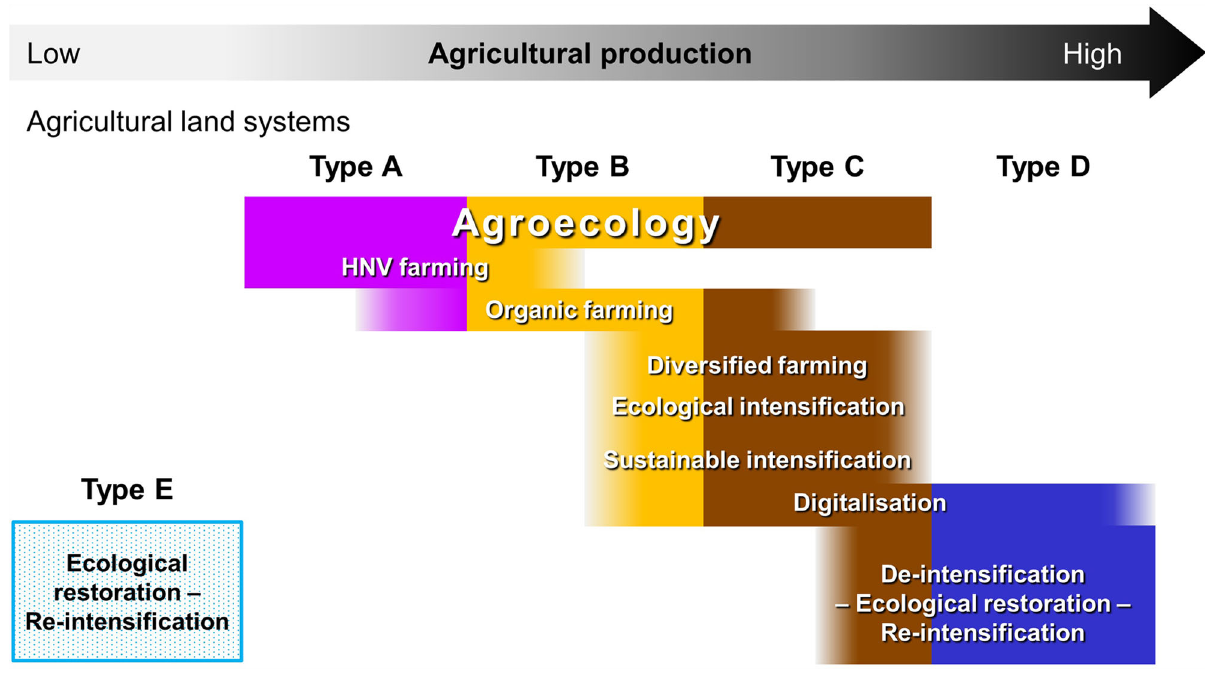
Fig. 2 Agroecology and other alternative farming approaches that share or may emphasise agroecological principles considered most suitable to enhance farmland biodiversity. Approaches are tailored to the characteristics of each type of agricultural land system (A to E, see Fig. 1). Colours refer to the types introduced in Fig. 1. Darker colours indicate better suitability of an approach for the respective agricultural land system. Note that approaches overlap as they share similar